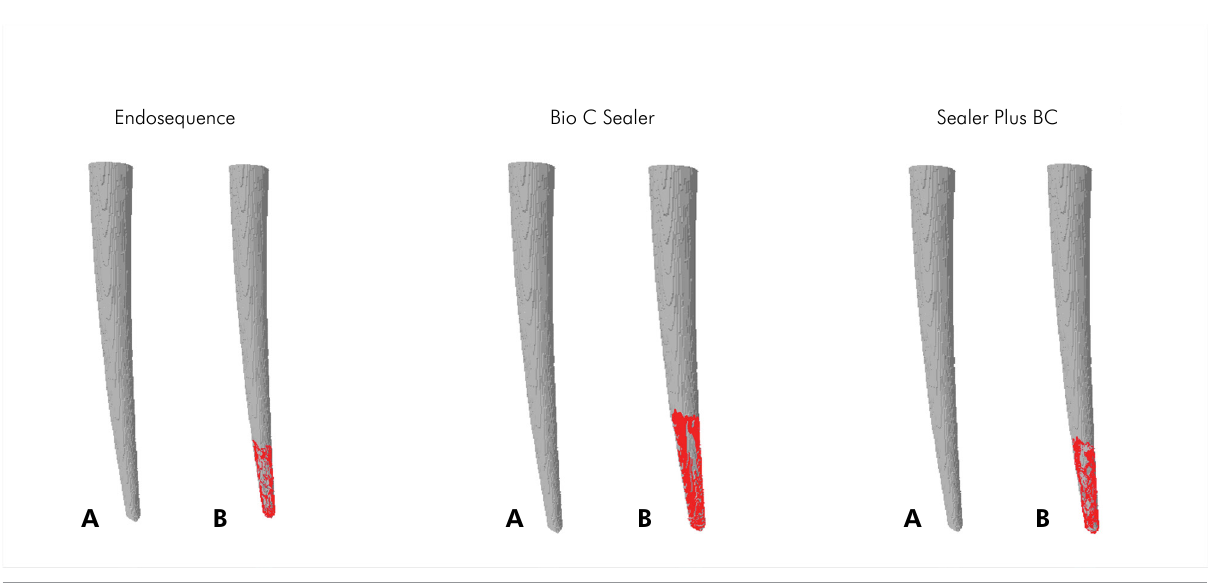
5 Braz. Oral Res.